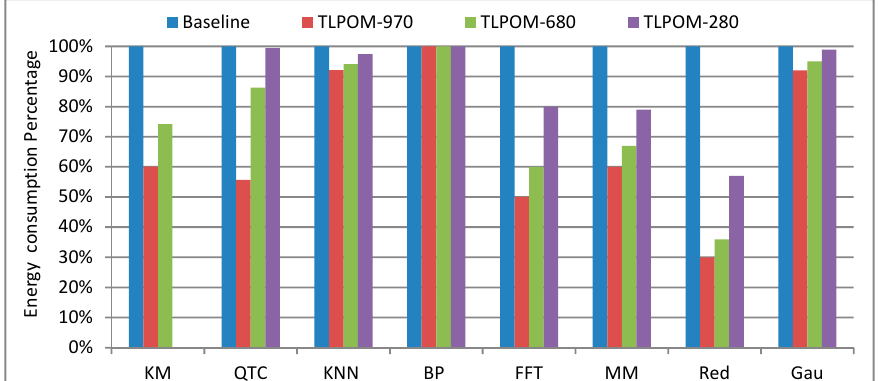
Figure 15. Energy consumption of data mining algorithms.